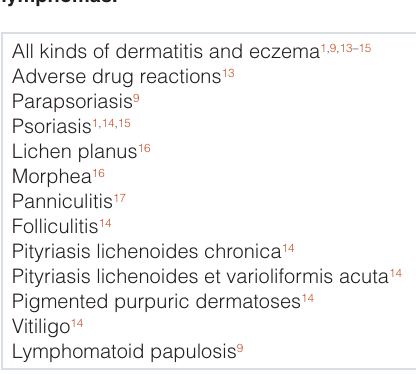
Table 1. The most important differential diagnoses of the cutaneous T cell